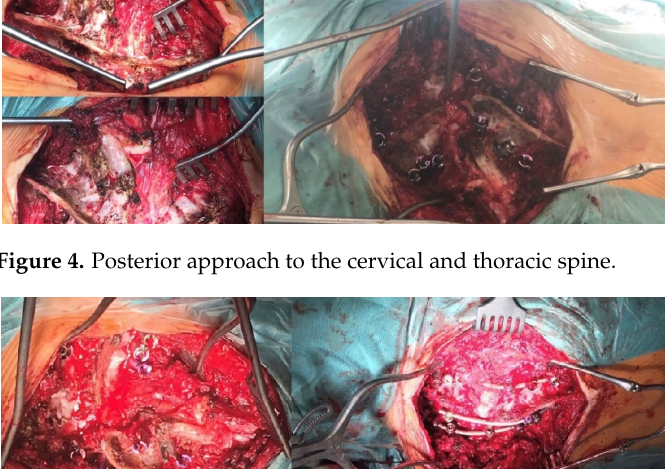
Figure 4. Posterior approach to the cervical and thoracic spine.